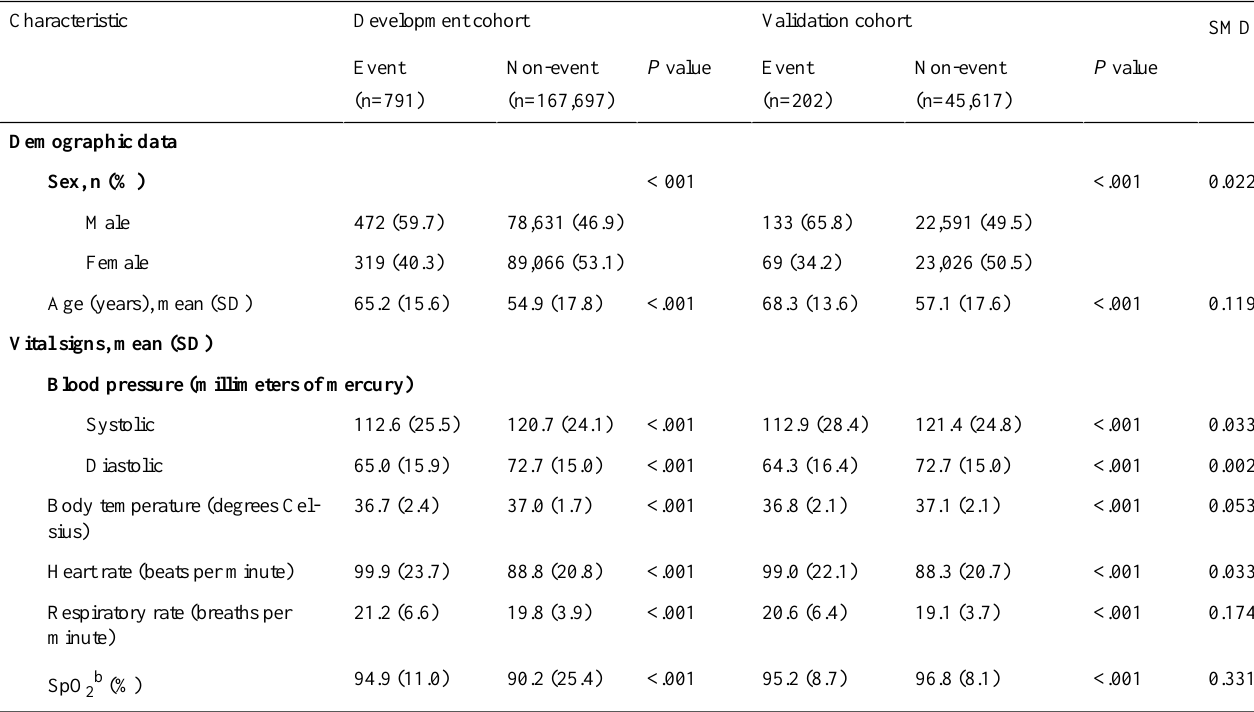
Table 1. Patient characteristics of the development and validation cohorts (N=214,307).